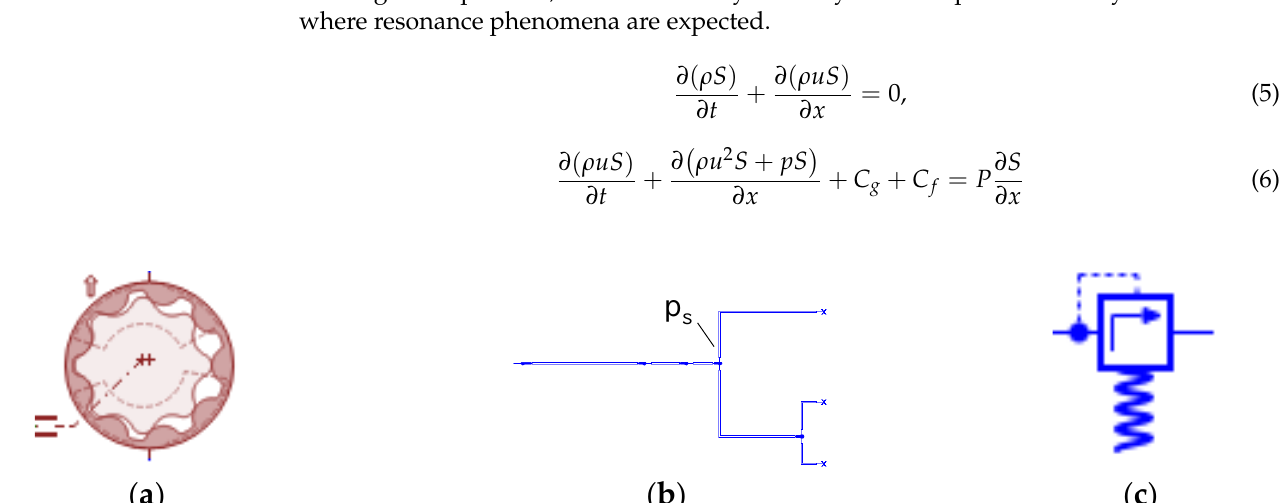
Figure 4. Components submodels: ( a ) Gerotor gear pump (HCDGP0); ( b ) Pipeline (HLLWx); ( c )